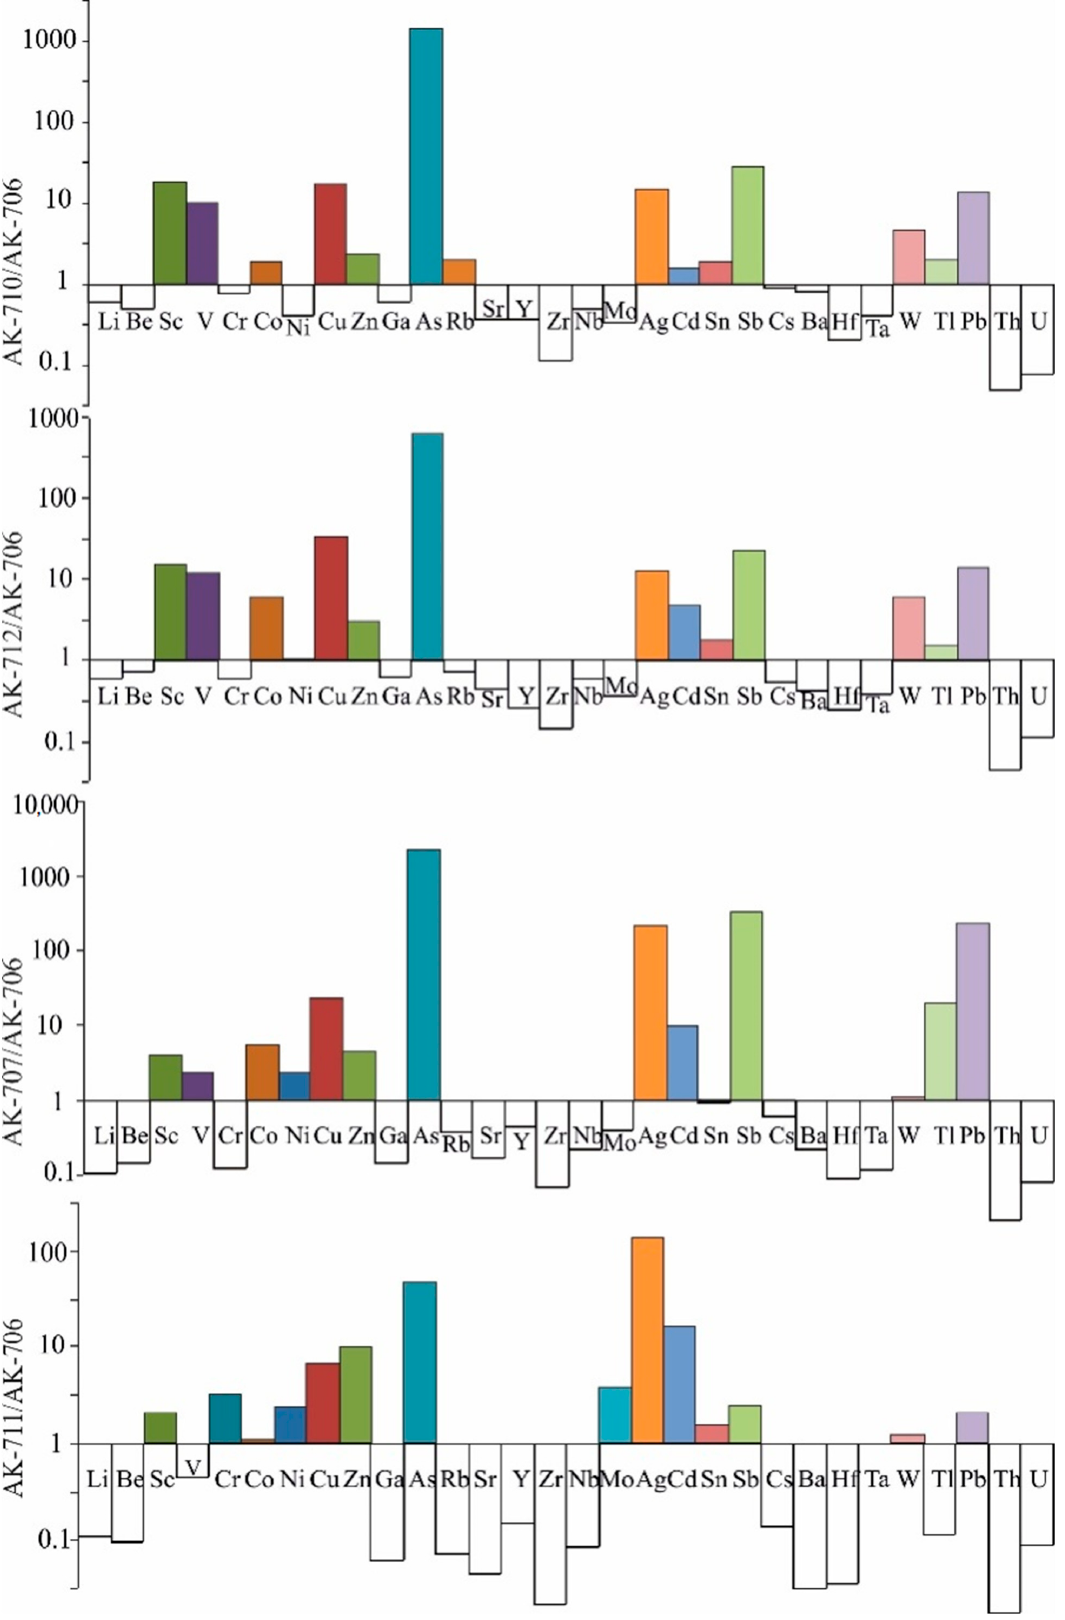
Figure 13. Trace elements spectra of quartz-albite-muscovite (AK-710 and AK-712), quartz-arsenopyrite-tourmaline (AK-707), and quartz (AK-711) metasomatic rocks from lens 2, compared to granite porphyry